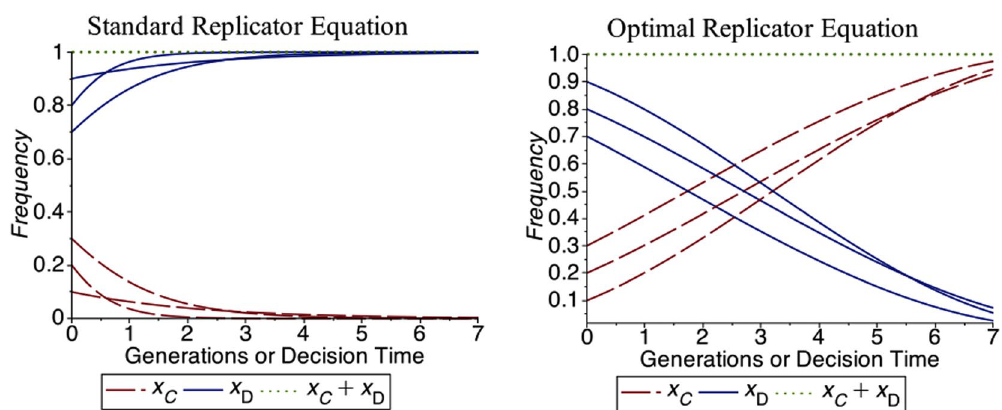
Figure 1. Evolution of cooperators (C) and defectors (D) in the PD. On the left panel we present the evolution according to the standard Replicator Equation, while the right panel is the evolution of the same system according to the Optimal Replicator Equation introduced here. The payoffs and the initial conditions used in these examples are reported in Table 1. While the standard RE predicts that cooperators disappear during evolution, the ORE shows the emergence of cooperation.